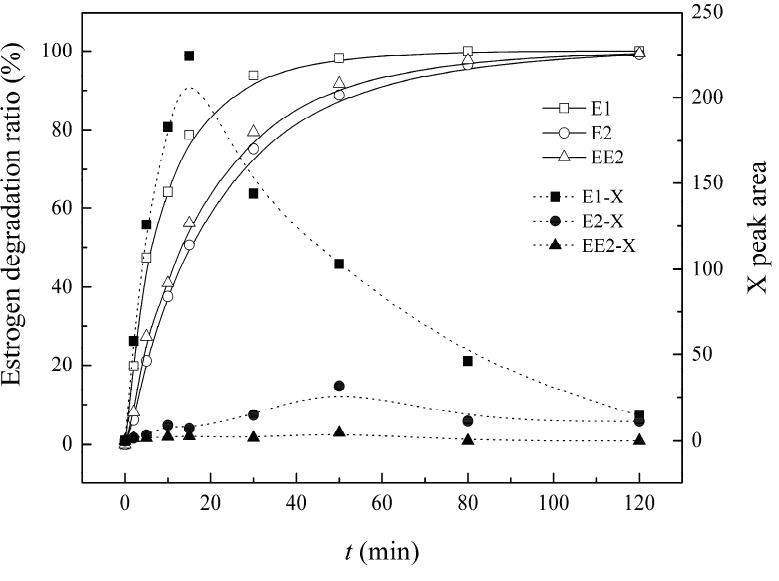
Figure 7. Variation of intermediate X along with single estrogen degradation in UV/H 2 O 2 system.